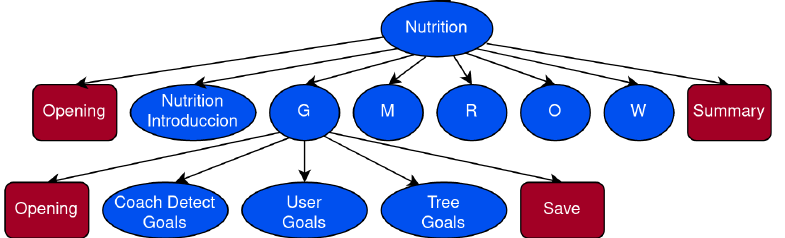
Figure 6. Task specification tree for the Nutrition agent. The sub-agent for the Goal (G) phase has been